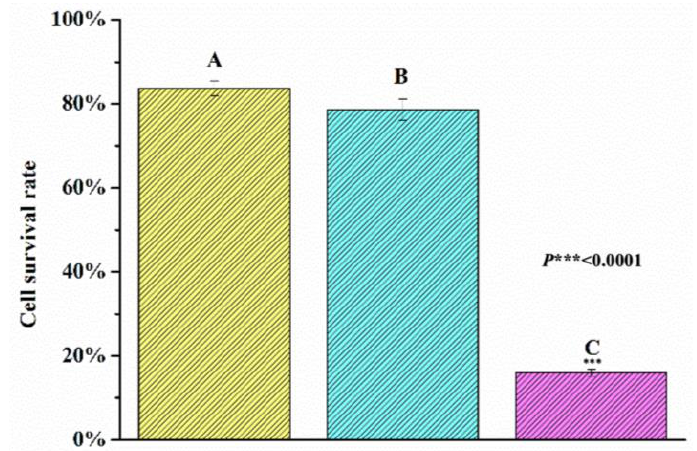
Figure 10. Cell survival rate of the HeLa cells treated with long-wavelength light irradiation: Control group ( A ), cultured with CUR-PC ( B ), and cultured with CUR-PC, then exposed to long-wavelength light irradiation ( C ).